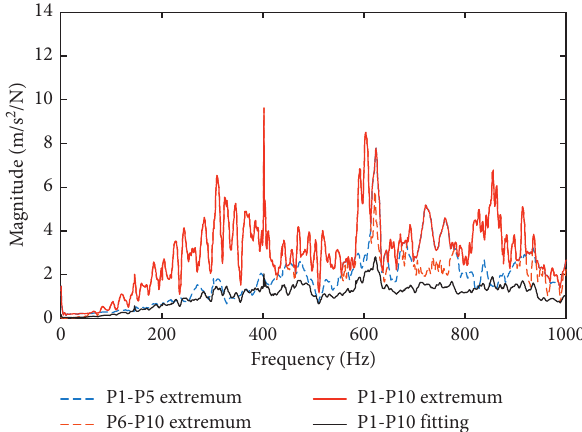
Figure 9: Equivalent FRF curves for P1-P10 obtained by the extremum method and fitting